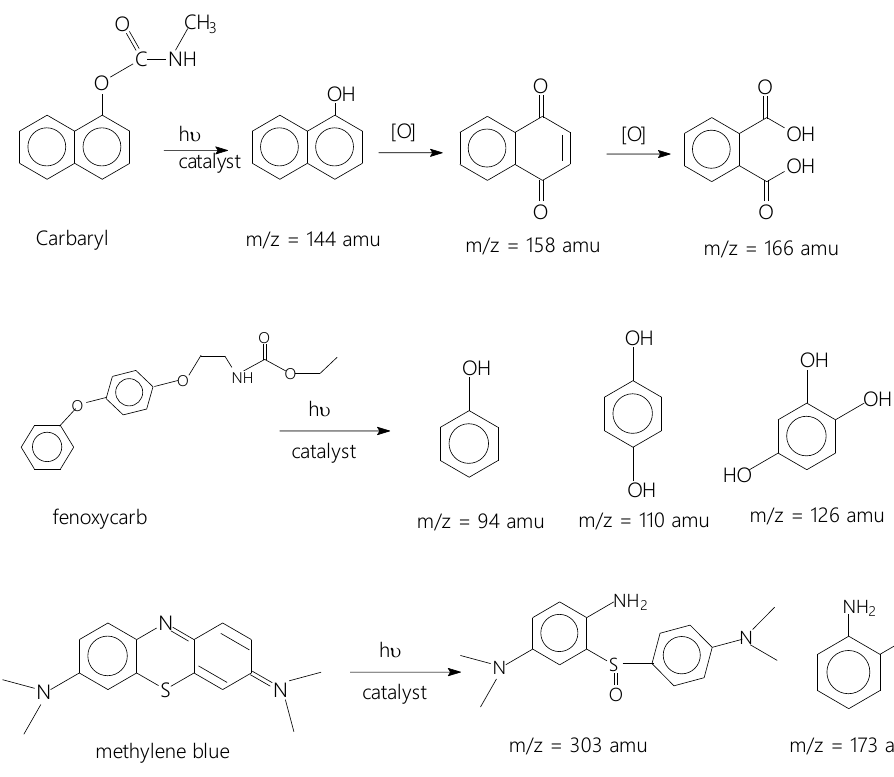
Figure 10. SSLS of the studied pesticides along with the Langmuir adsorption profile obtained for ( A ) carbaryl and ( B )